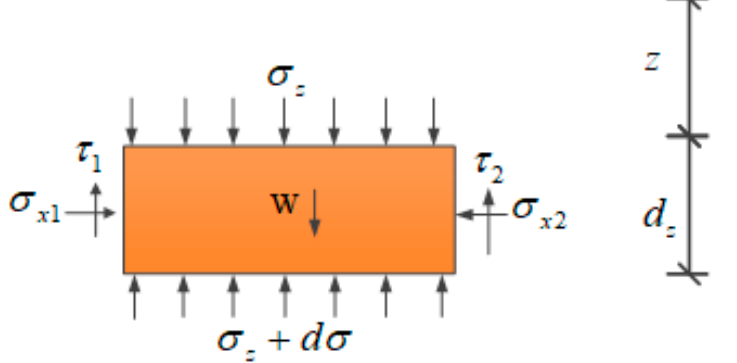
Figure 6. A slice element mechanical model of part Ⅱ .